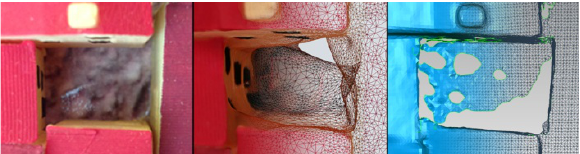
Fig. 7. Detail of a small and deep courtyard: on the left, the real scale model; in the middle, 123DCatch finds an average round geometry; on the right, the scan leaves holes instead of proposing a fake